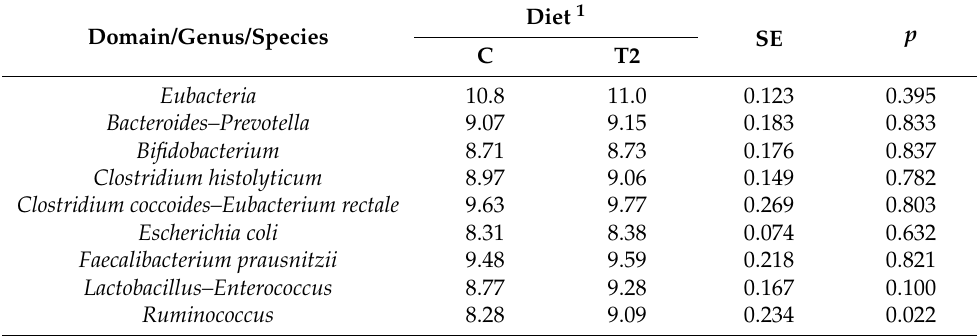
Table 5. Analysis of the effect of dietary treatment on intestinal microbial composition. Data are given as means per treatment and expressed as (Log 10 n)/g DM.